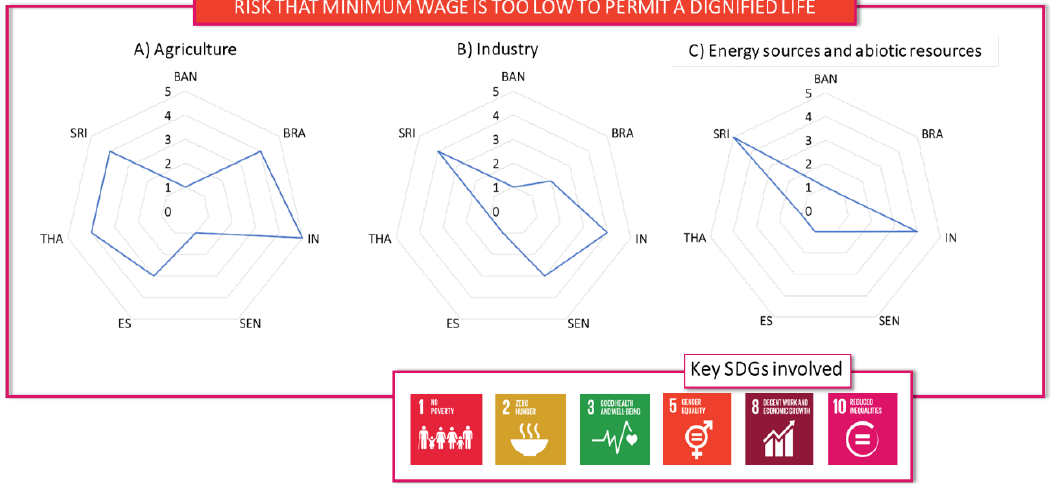
Figure 7. Risk that the minimum wage is too low to permit a dignified life